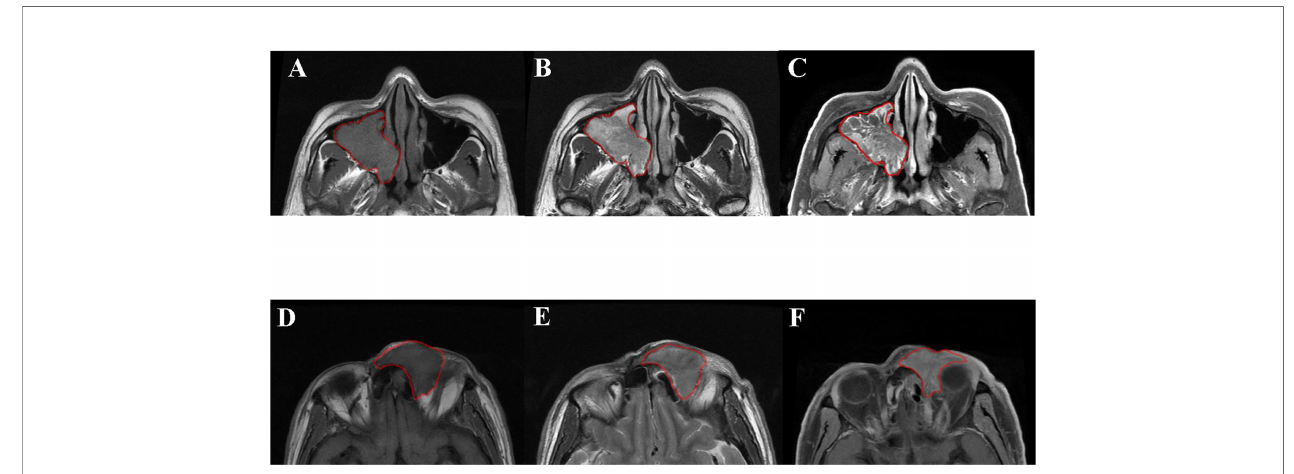
FIGURE 4 | Patient 1: axial T1WI (A) , axial T2WI (B) , and axial contrast-enhanced T1WI (C) . A 48-year-old man was pathologically diagnosed as inverted papilloma in the right nasal cavity and maxillary sinus, with severe epithelial atypical hyperplasia and carcinogenesis. The presence of convoluted cerebriform pattern and absence of extra-sinonasal involvement led to a misclassi fi cation as benign by the two radiologists, whereas the radiomic model well-classi fi ed it as malignant. Patient 2: axial T1WI (D) , axial T2WI (E) , and axial contrast-enhanced T1WI (F) . A68 year-old man was pathologically diagnosed as an inverted papilloma in the left frontal sinus and, with squamous cell carcinoma in some areas. In this case, orbital invasion was a key feature of malignancy easily seen by radiologists. The two radiologists well-classi fi ed the case as malignant, whereas the radiomic model misclassi fi ed it as benign.